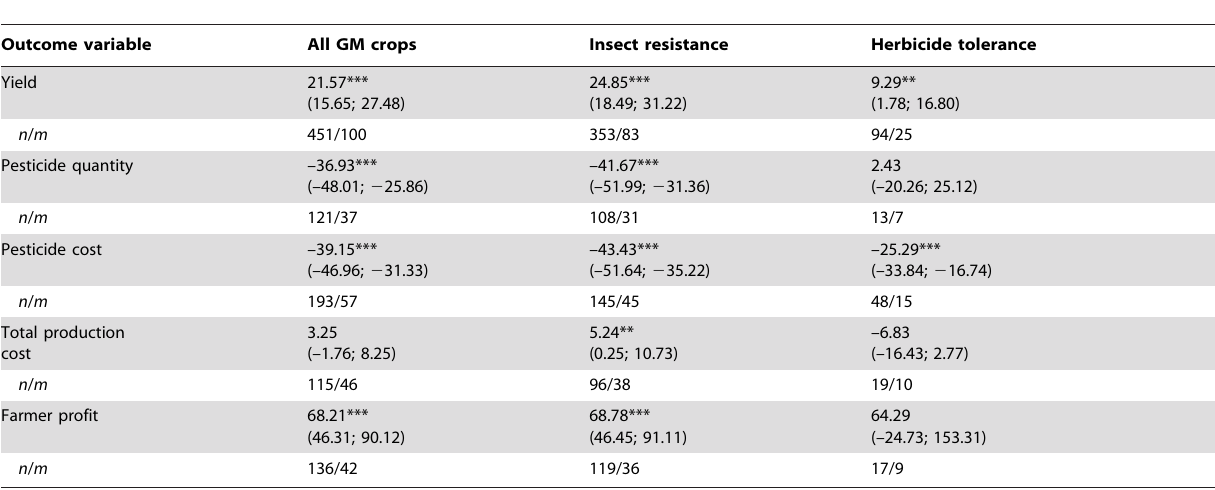
Table 2. Impacts of GM crop adoption by modified